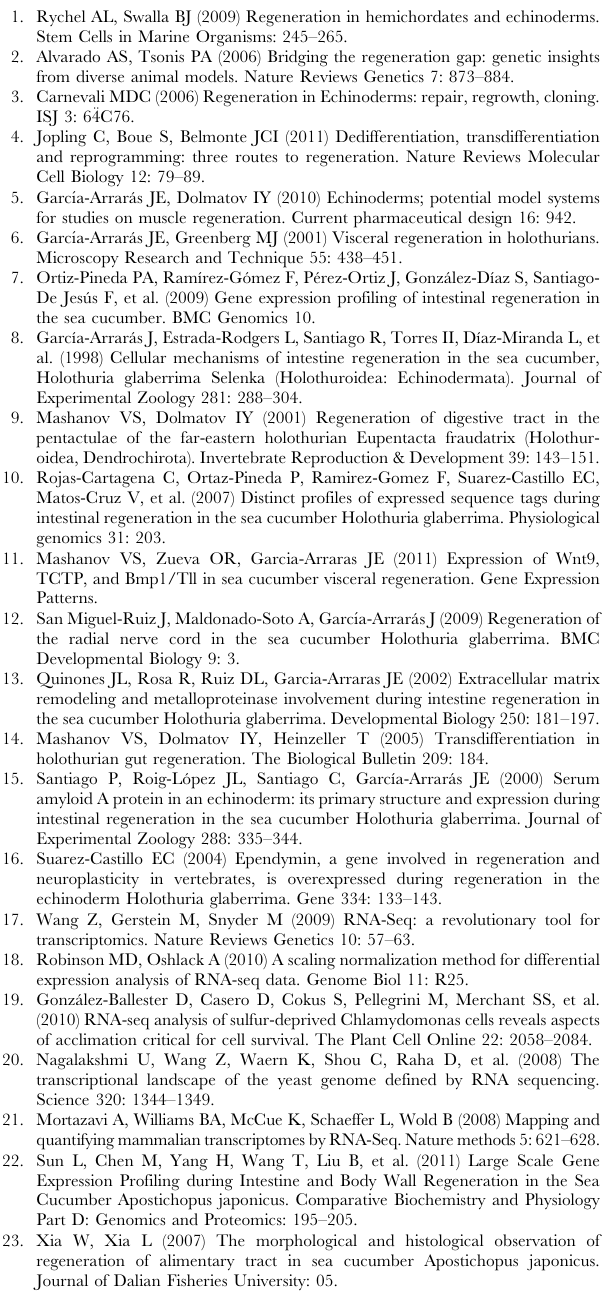
Table S4 All differential expressed genes at 7dpe Vs Normal. (XLS) Table S5 All differential expressed genes at 14dpe Vs Normal. (XLS) Table S6 All differential expressed genes at 21dpe Vs Normal. (XLS) Table S7 The DEGs (isotigs) in enriched Pathways. (XLS)